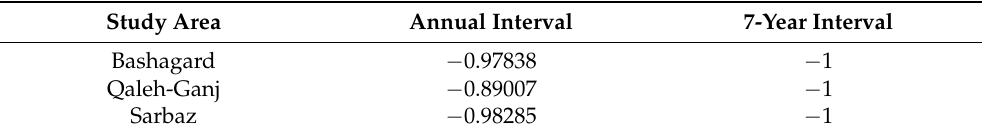
Table 6. Correlation between effective environmental factors of Bashagard County.